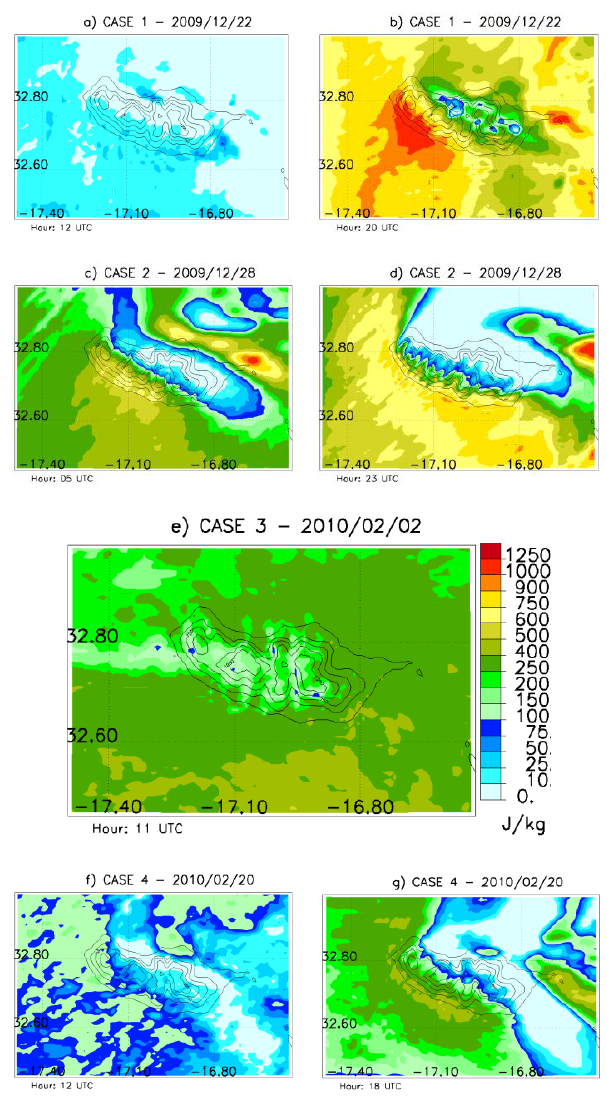
Figure 10. Convective Available Potential Energy (J/kg) simulated with the MESO-NH 2 Fig. 10. Convective Available Potential Energy (Jkg − 1 ) simulated with the MESO-NH Model for (a) 22 December 2009 – 12:00UTC, Model for (a) 22/DEC/2009 – 12 UTC, (b) 22/DEC/2009 – 20 UTC, (c) 28/DEC/2009 – 05 3 UTC, (d) 28/DEC/2009 – 23 UTC, (e) 02/FEB/2010 – 11 UTC, (f) 20/FEB/2010 – 12 UTC, 4 and (g) 20/FEB/2010 – 18 UTC. 5